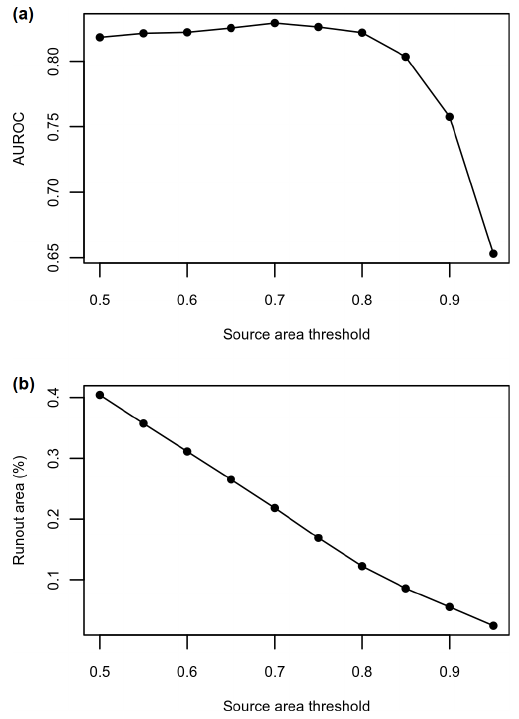
Figure 8. Performance of debris-flow runout model for different source-area thresholds (a) and percentage of study area impacted by runout (b) . Optimal threshold was a threshold of 0.70 (AUROC = 0.83) with runout affecting 22% of the study